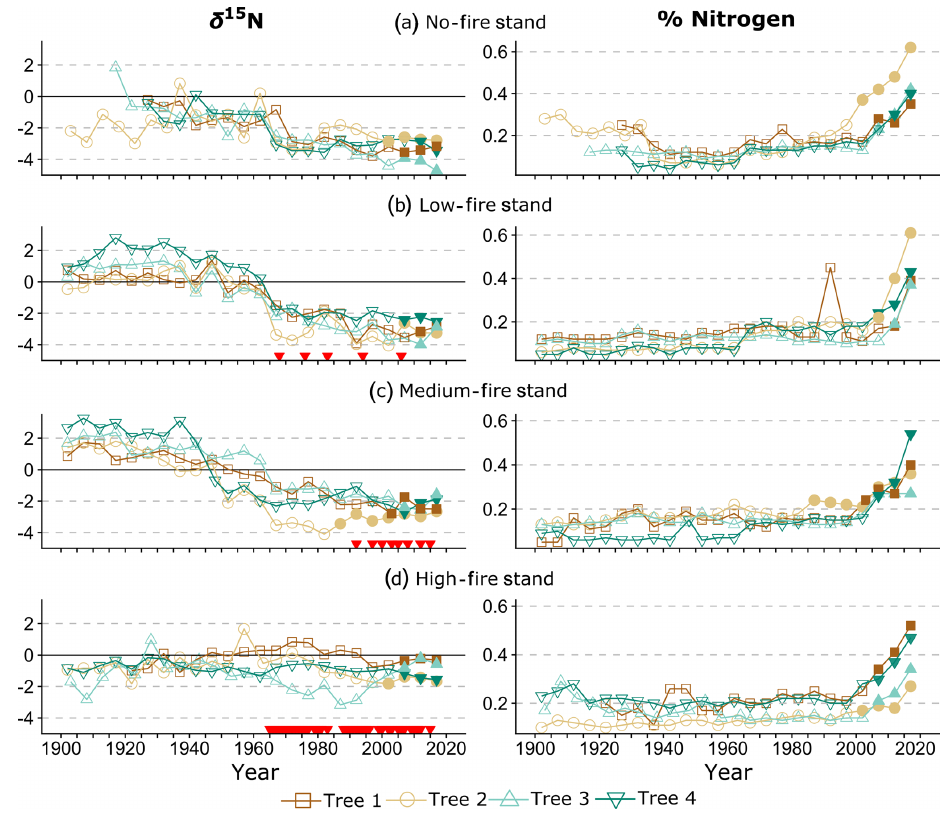
Figure 4. Wood δ 15 N (left) and %N (right) data over time. Lines connect data for individual trees within each stand. Shapes and colors correspond to trees 1–4 in each stand (Table 1). On the left, red triangles indicate individual years of prescribed fire in each treatment stand. Filled shapes indicate wood sampled after the heartwood–sapwood transition. Wood %N increased in all trees over the last 115 years, with the sharpest increases after the heartwood–sapwood transition (average transition year